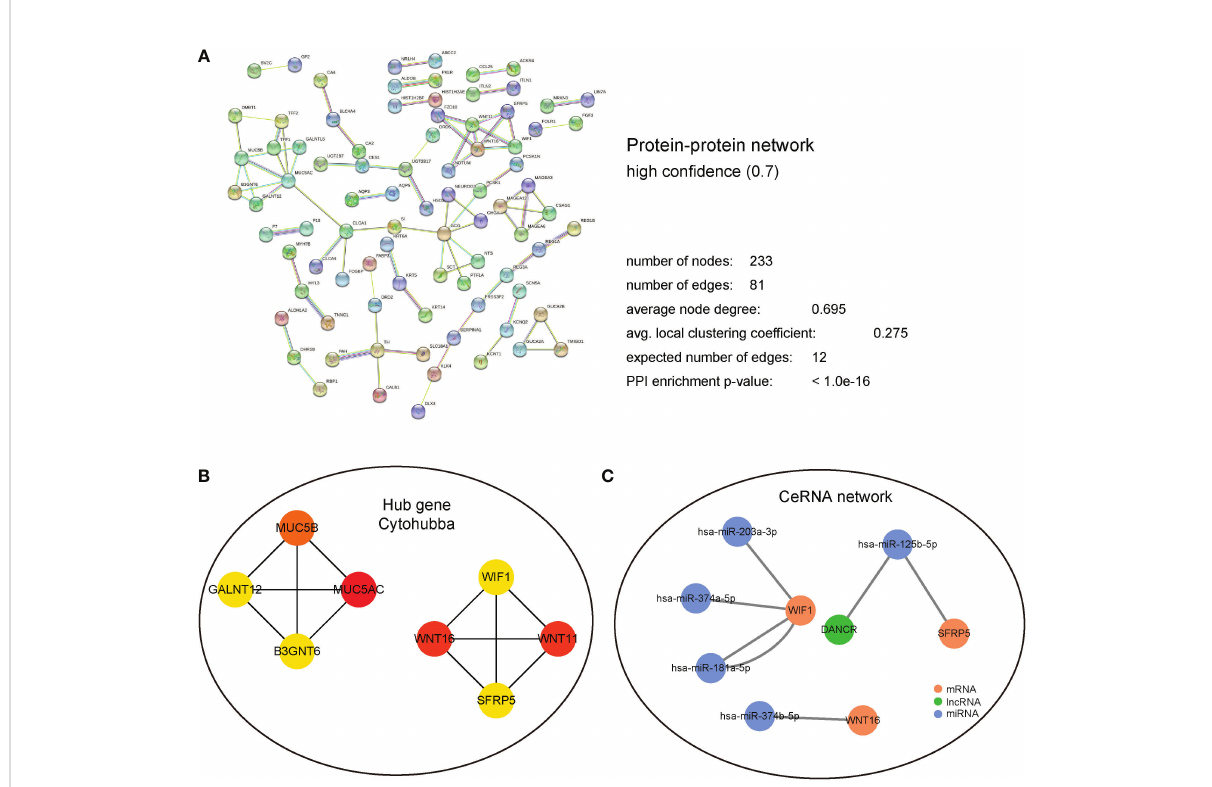
FIGURE 6 PPI and regulatory network analysis. (A) PPI regulation network, detailed display of the network node information, connection line information, and the composition of the different sub-network information. (B) Hub gene regulation network based on cytoHubba calculation. (C) CeRNA regulatory network predicted using the miRTarBase database. Blue represents miRNA; green represents LncRNA; and Brown represents